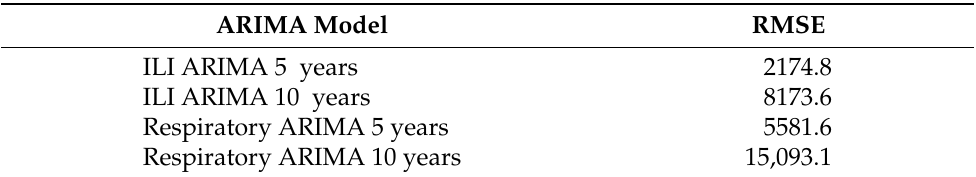
Table 5. The RMSE of ARIMA Model